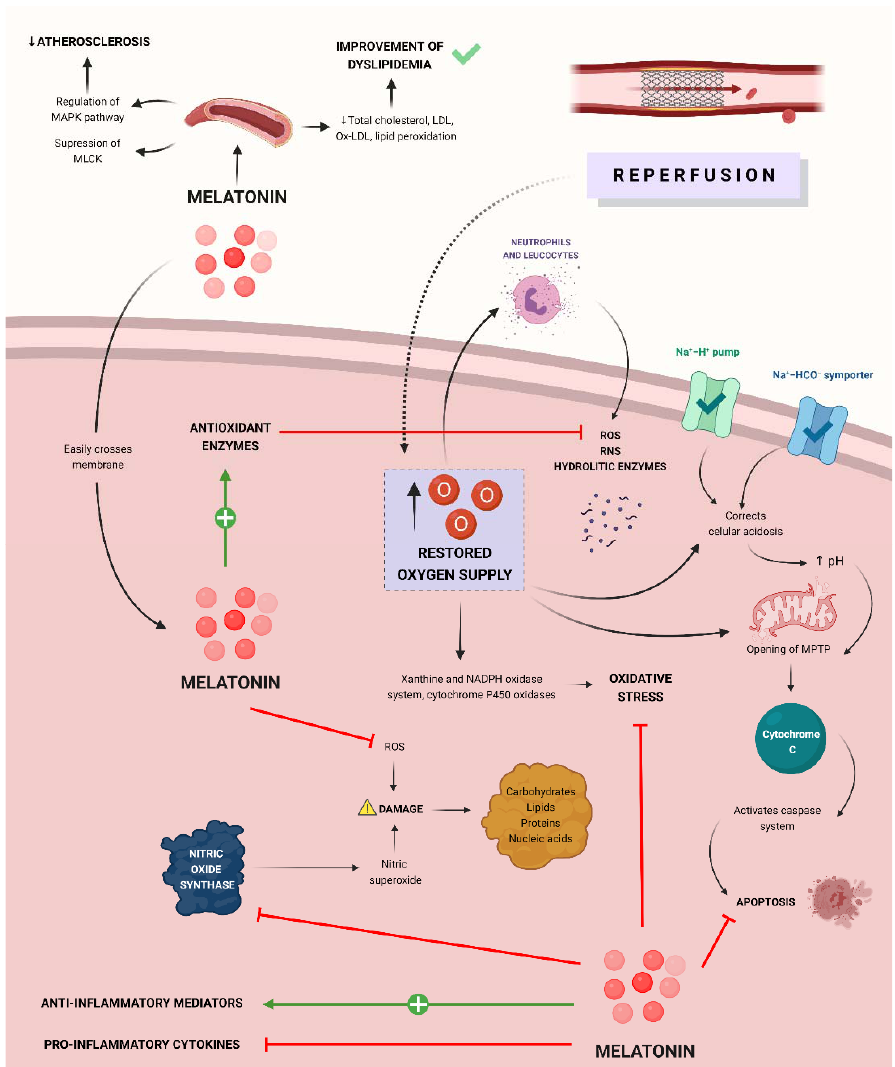
Figure 3. Mechanisms through which melatonin exerts myocardial protection in MI/R injury. Melatonin is capable of inhibiting the nitric oxide synthase, pro-inflammatory cytokines, ROS, and cellular pathways conducting to apoptosis. It is also responsible for enhancing anti-inflammatory mediators and antioxidant enzymes. Extracellularly, melatonin decreases atherosclerosis and improves dyslipidemias, which reduce the risk of ischemic episodes.